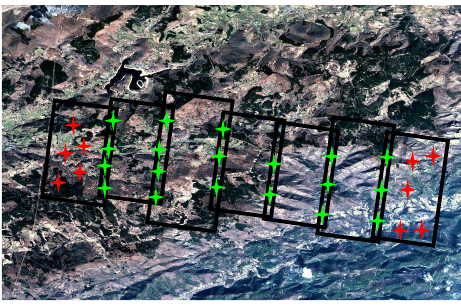
Figure 5 : Multi-pass